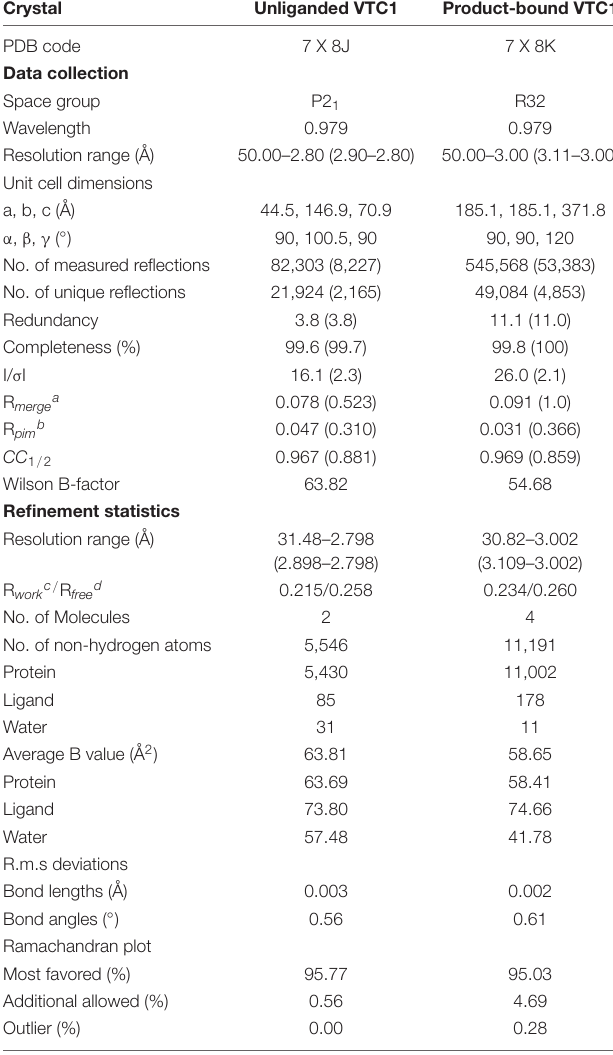
TABLE 1 | Data collection and refinement